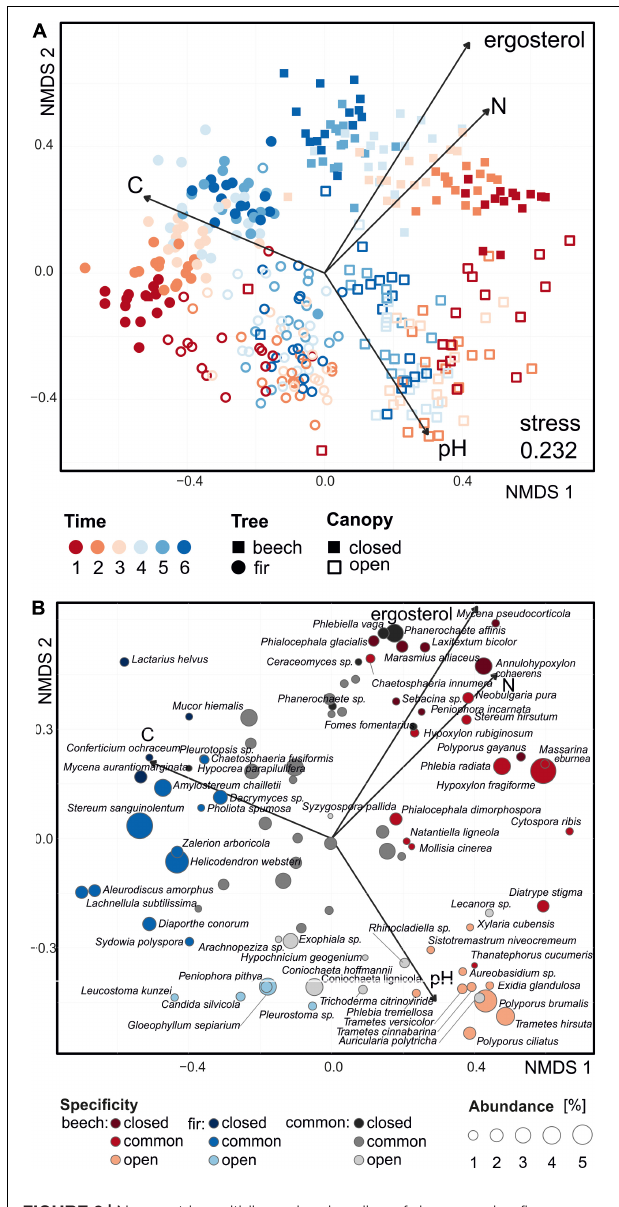
FIGURE 2 | Non-metric multidimensional scaling of decomposing fine deadwood of beech and fir under different microclimatic conditions in a natural temperate forest based on dissimilarities among samples. Analysis was based on Euclidean distances on Hellinger-transformed relative abundances. Vectors indicate environmental variables with significant correlations with NMDS results ( P < 0.05). (A) Samples are represented by points. OTUs with relative abundances over 0.5% in at least three samples were included. (B) Each point represents the abundant species and its specificity for substrate and microclimatic conditions. The size of the point is scaled based on the relative average abundances in all samples. Species with maximal abundances over 5% in at least three samples are